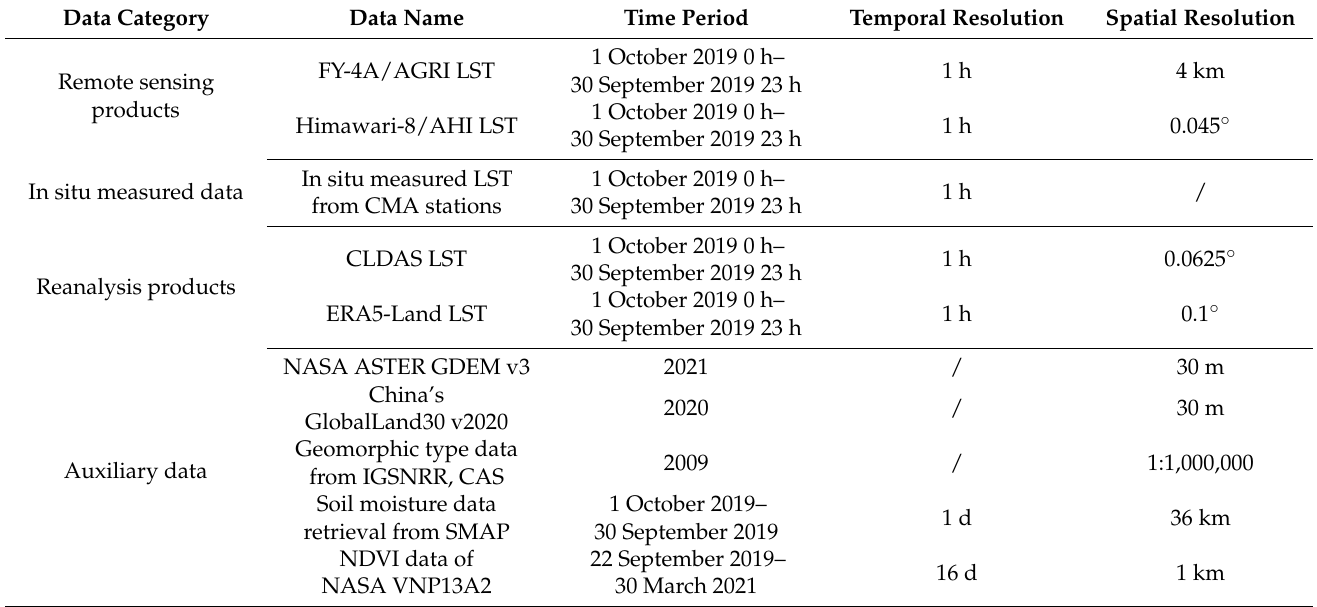
Table 1. Datasets used in this